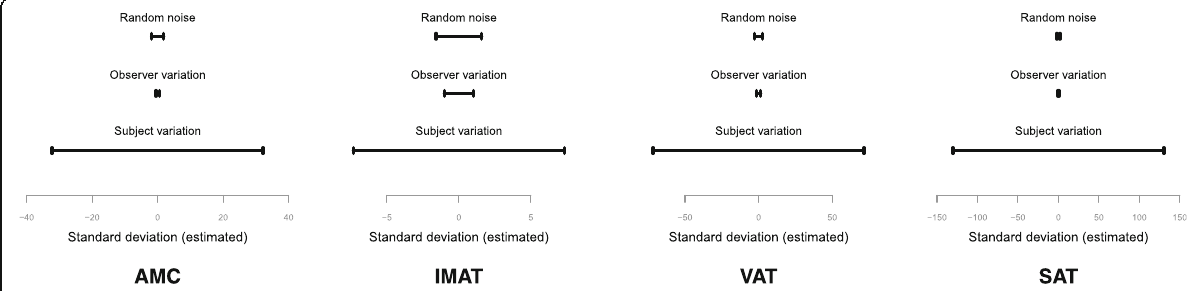
Fig. 3 Distribution of variation between random noise, observer and subject for each segmented tissue. AMC abdominal muscle compartment, IMAT inter- and intramuscular adipose tissue, VAT visceral adipose tissue, SAT subcutaneous adipose tissue